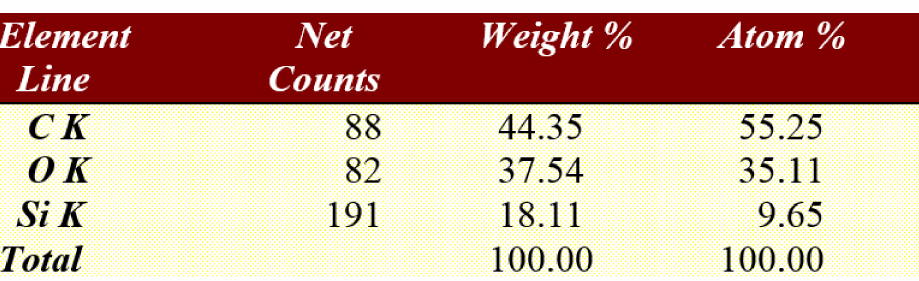
Figure 9. EDX result of ceramic bracket.